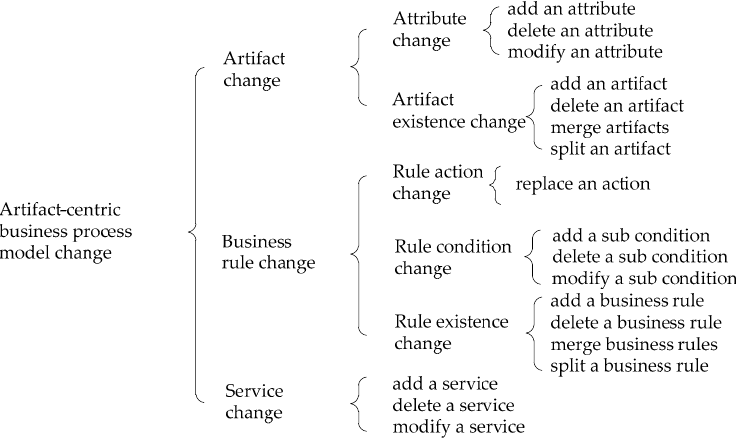
Figure 2. The taxonomy of changes of an artifact-centric business process.